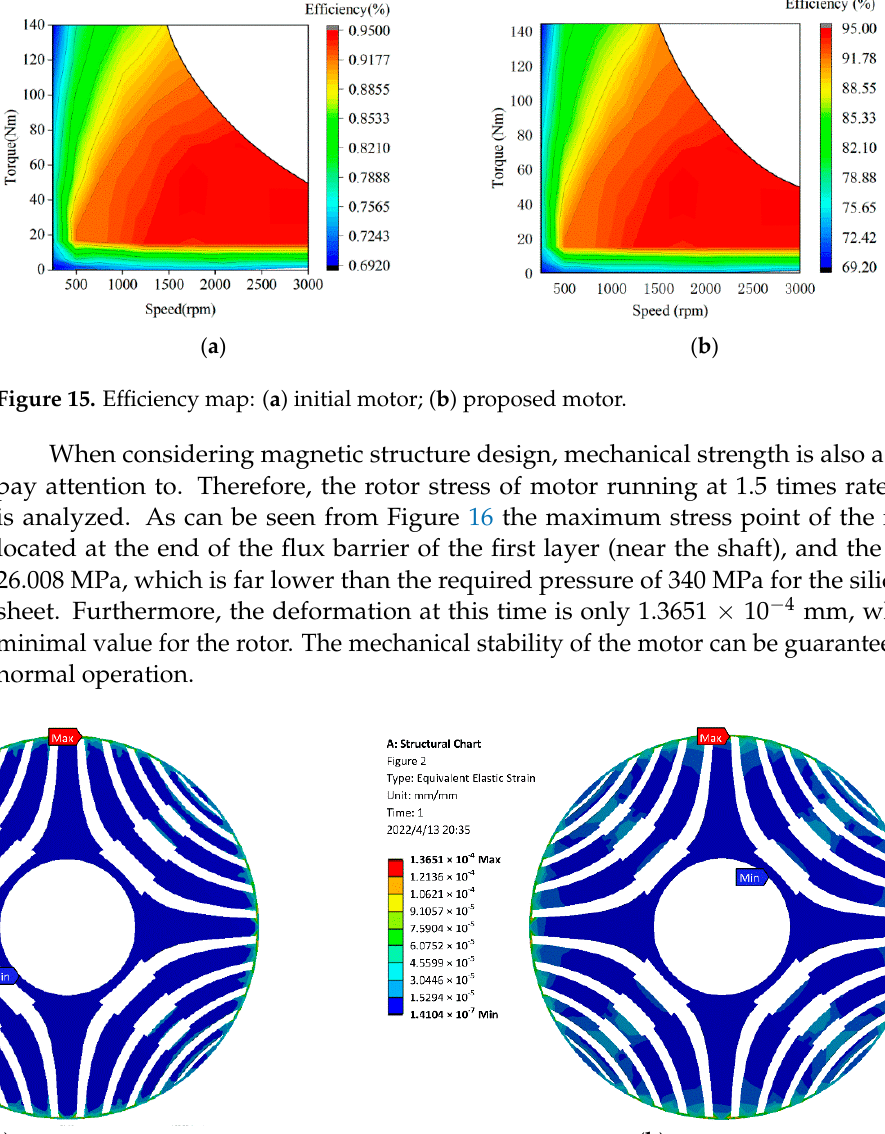
19 of 21 Figure 14. Flux line distribution: ( a ) initial motor; ( b ) proposed motor. Table 2 show the output characteristics of initial model and proposed motor. As can be seen from the table, the performance of the proposed motor is better than that of the first motor, with lower core loss and stranded loss and higher efficiency. At the same time, the sensitivity of the proposed motor is lower than that of the initial motor, which verifies the feasibility of the proposed method. Table 2. Output characteristics of initial motor and proposed motor. Contents